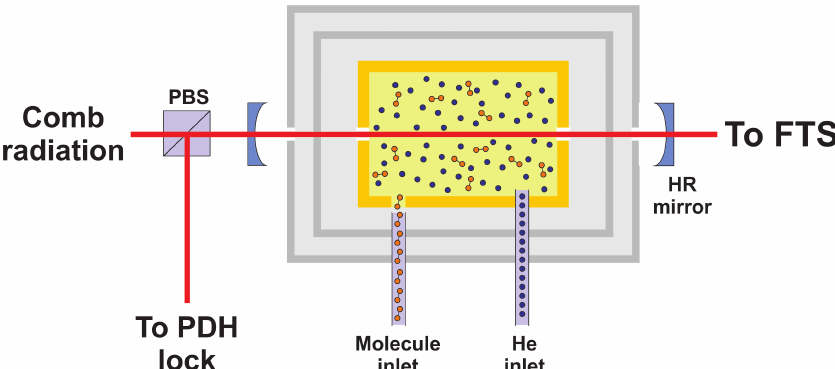
Figure 4. Simplified view of the apparatus used for CE-DFCS of buffer-gas-cooled gas-phase complex molecules. MIR frequency comb light is coupled to a high-finesse ( (cid:39) 6000 both at 3 and 8.5 µ m wavelength) cavity surrounding the 10-K buffer gas cell. Comb light reflected from the cavity is used to generate a Pound–Drever–Hall (PDH) error signal to lock the comb to the cavity. The PDH lock guarantees efficient on-resonance cavity transmission over a simultaneous transmission bandwidth of 100 nm (limited by dispersion of the HR mirrors); the spectrum of the transmitted comb light is read out by a Fourier-transform (FT) spectrometer or a VIPA. By adjusting the cavity free-spectral-range (FSR), an 8:5 or 2:1 f rep -to-FSR ratio can be selected. Comb modes not resonant with the cavity are rejected, resulting in a sparser transmitted comb spectrum, which facilitates single comb mode resolution with the FTS or VIPA. Adapted from